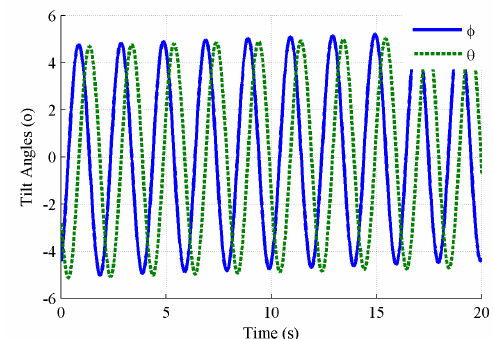
Figure 8. Tilt angles of the MEMS inclinometer at a conical motion around the Z-axis.